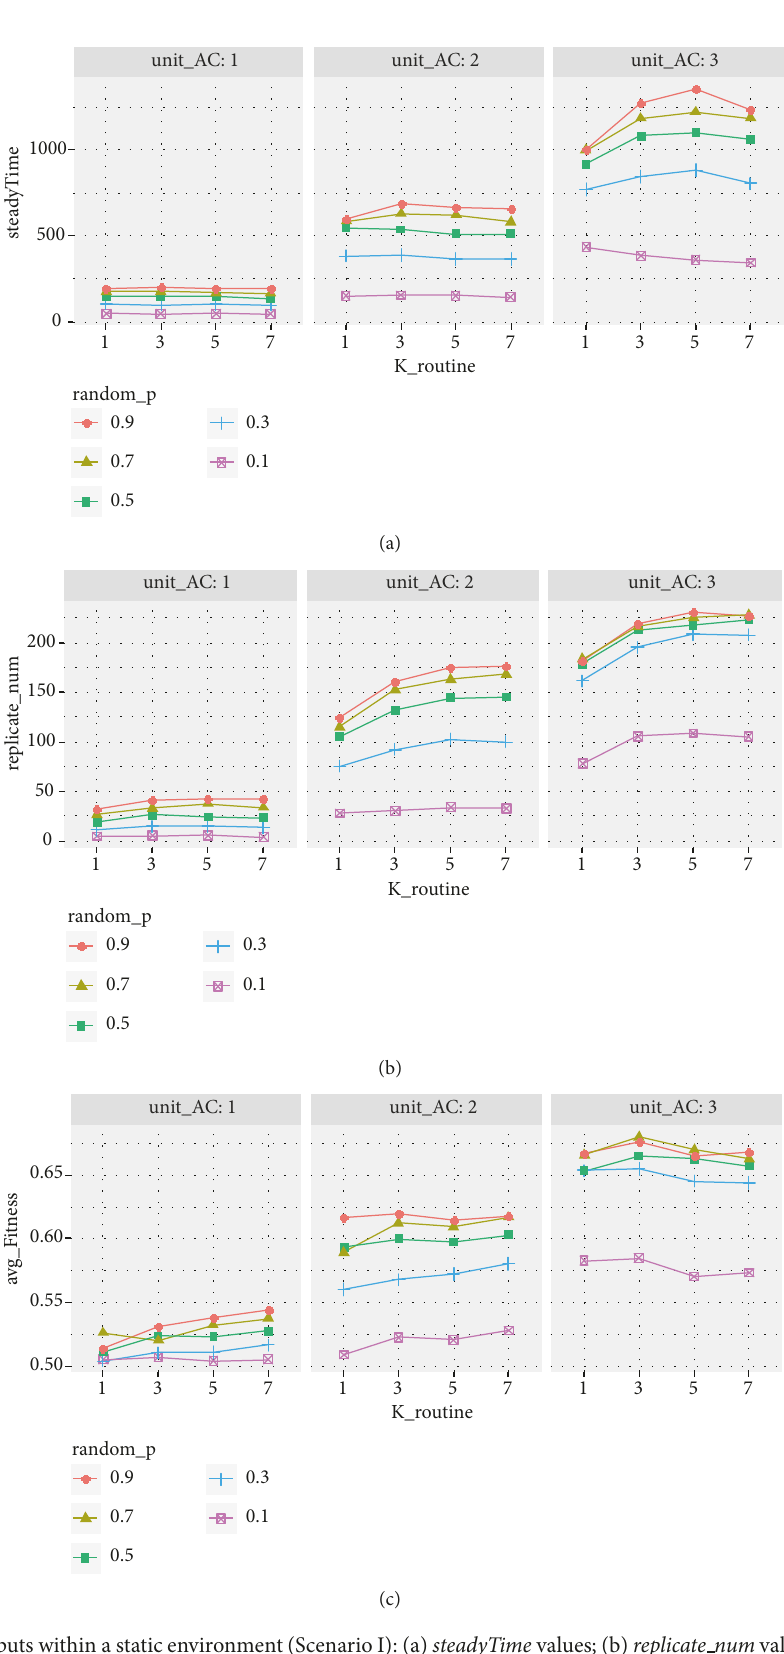
Figure 6: Simulation outputs within a static environment (Scenario I): (a) steadyTime values; (b) replicate num values; (c) avg Fitness